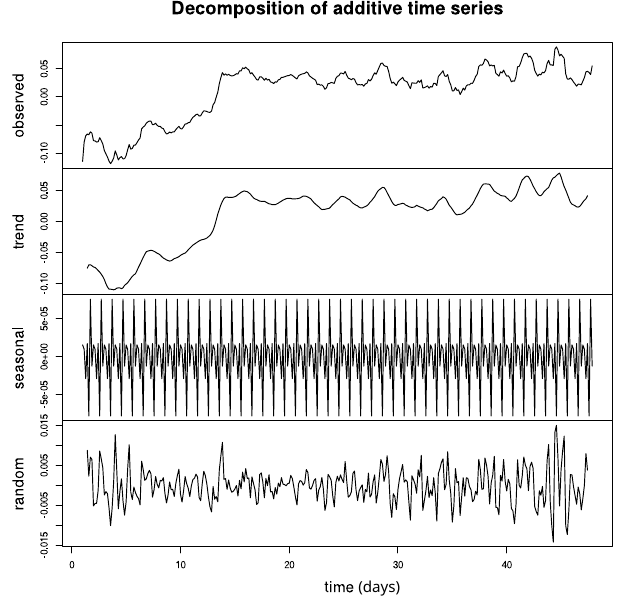
Figure 6. Year–Long time series of daily averaged compounded sentiment polarity of COVID-19-related tweets, utilizing BERTweet in Mexico . Shown is the decomposed sentiment analysis: the averaged time series, trends, weekly seasonality, and random data. The time axis is shown in days, starting from